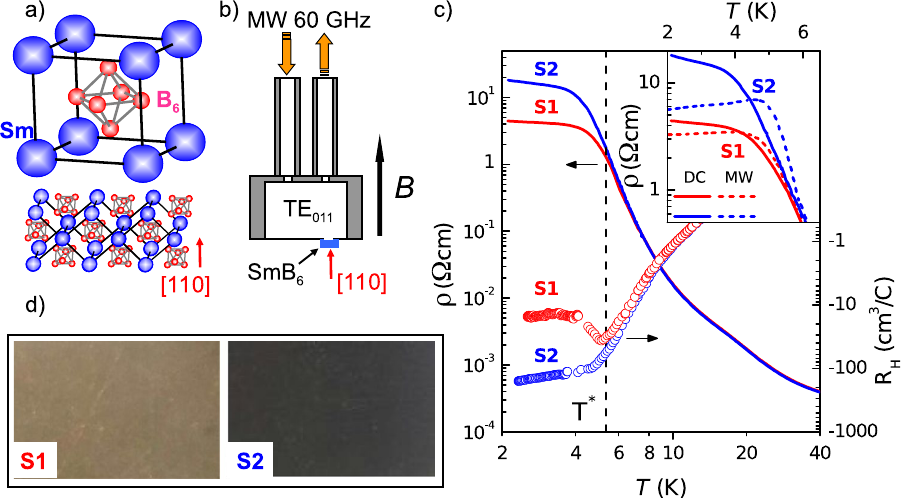
Figure 1. Unit cell and [110] surface of SmB 6 ( a ), experimental layout used for microwave experiments ( b ); DC resistivity and Hall effect data ( c ) and the views of the SmB 6 [110] surface states S1 and S2 in optical microscope with 4x magnification ( d ). Inset in panel c presents the comparison of the DC resistivity and inversed microwave conductivity for the different states of [110]